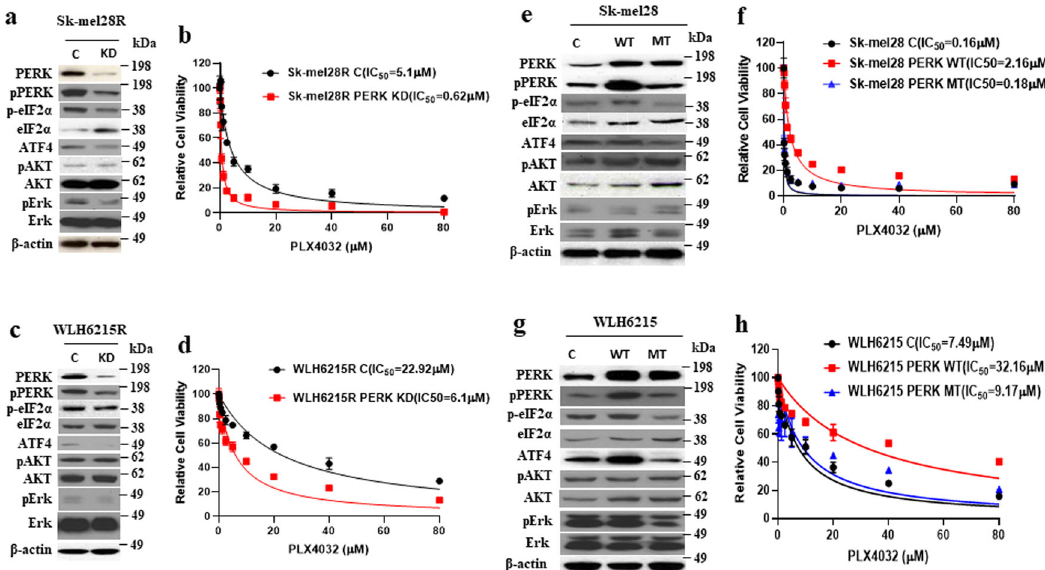
Fig. 3 PERK affected the ability of resistance to BRAF inhibitors in melanoma with impaired PTEN. a , b and c , d Knock-down of PERK enhances the sensitivity to BRAFi in PTEN impaired melanoma. a , c Western blotting showed the indicated protein level in PERK knockout cells from Sk-mel28R ( a ) and WLH6215R ( c ). C, empty vector; KD, PERK knock-down. b , d BRAFi-resistant Sk-mel28R (Sk-mel28R C) and its PERK knock-down (Sk-mel-28R PERK KD) or WLH6215R (WLH6215R C) and its PERK knock-down (WLH6215R PERK KD) cells were treated with different concentrations of BRAF inhibitor PLX4032. The cell viability curves of Sk-mel28R (Sk-mel28R C) and its PERK knock-down (Sk-mel- 28RPERK KD) ( b ) or WLH6215R (WLH6215R C) and its PERK knock-down (WLH6215R PERK KD) ( d ) human melanoma cells were determined using CCK8 assays. Error bars denote s.d. for biological three repeats. e , f and g , h Overexpression of PERK can increase the ability of resistance to BRAFi in PTEN impaired melanoma. e , g Western blotting showed the indicated protein level in PERK overexpressing cells from Sk-mel28 ( e ) and WLH6215 ( g ). C, empty vector; WT, wild-type PERK; MT, mutant PERK. f , h Cell viability curves of Sk-mel28 (Sk-mel28 C) and its overexpressing (Sk-mel28 PERK WT and Sk-mel28 PERK MT) ( f ) or WLH6215 (WLH2615 C), and it ’ s overexpressing (WLH2615 PERK WT